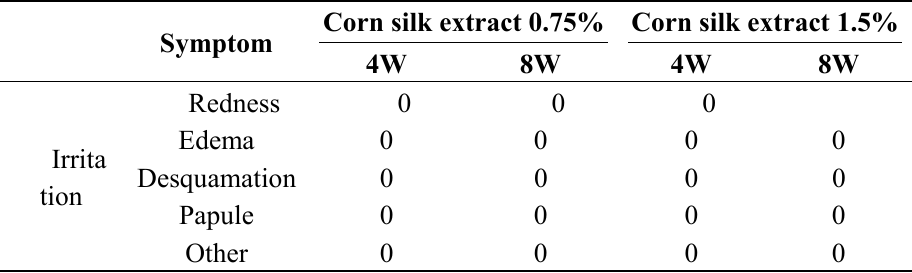
Table 2. Adverse skin reactions ( n = 21 for each group, number of